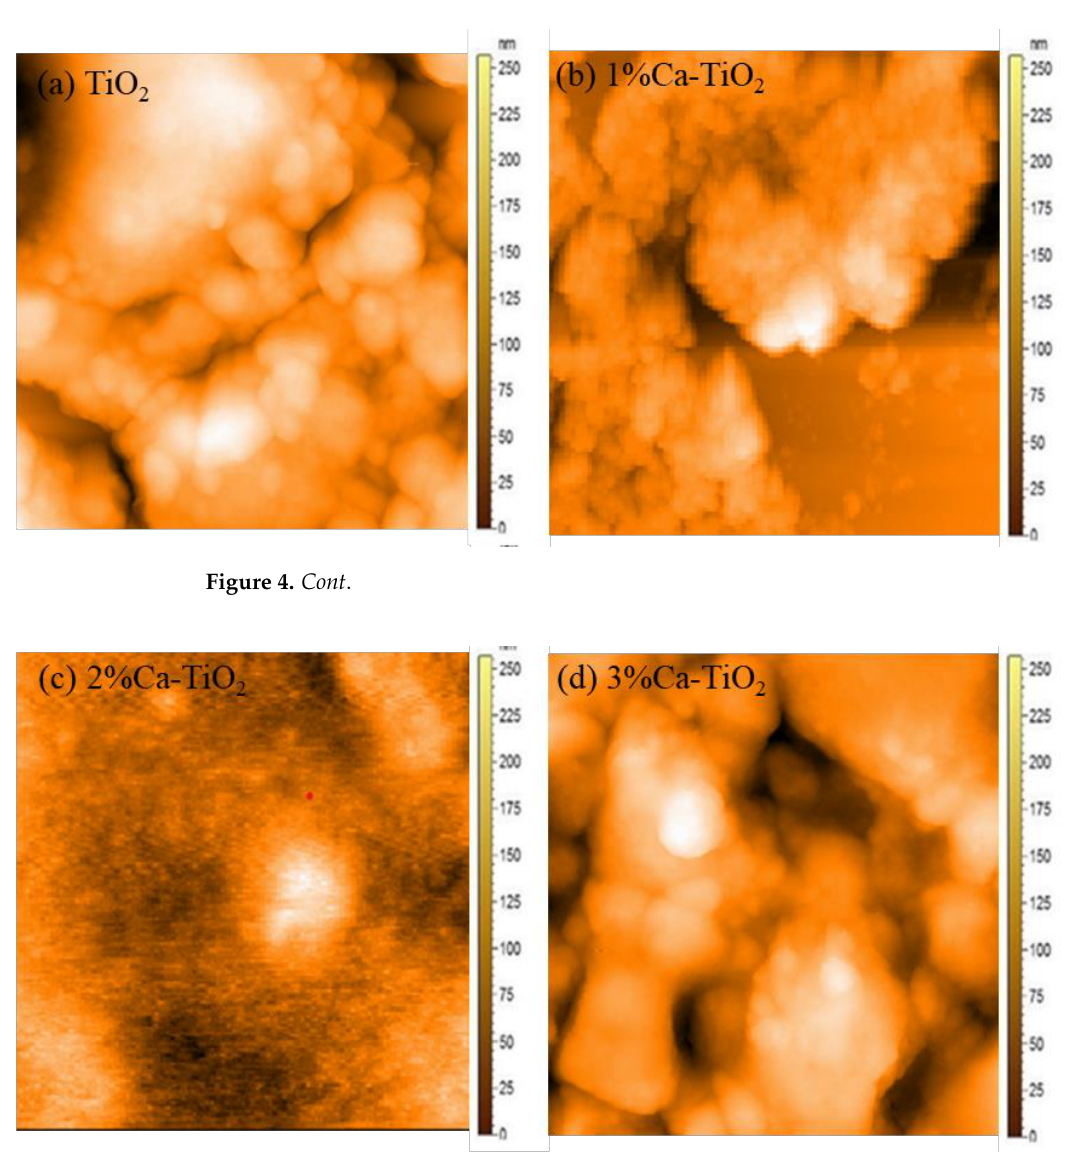
Figure 4. AFM images of ( a ) TiO 2 , ( b ) 1% Ca-TiO 2 , ( c ) 2% Ca-TiO 2 , and ( d ) 3% Ca-TiO 2 . In addition, the roughness parameters (Ra) and the root mean square (Rq) is measured and shown in Figure 5a,b, respectively, and the relative values are shown in Table 2. The roughness for TiO 2 is higher as compared to the Ca-doped TiO 2 samples. The Ca-doped TiO 2 samples demonstrated a continuous decrease in the roughness parameters associated with the increase in the Ca loading [39] that help the uniformity of thin Table 2. Mean roughness (Ra) and root mean square roughness (Rq) of prepared ETL. S.No.